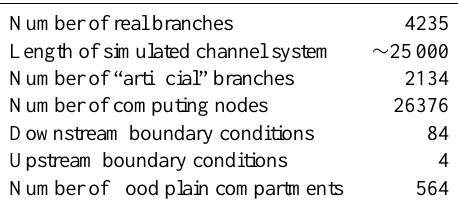
Fig. 3. The model river network including Tonl´e Sap – Great Lake.